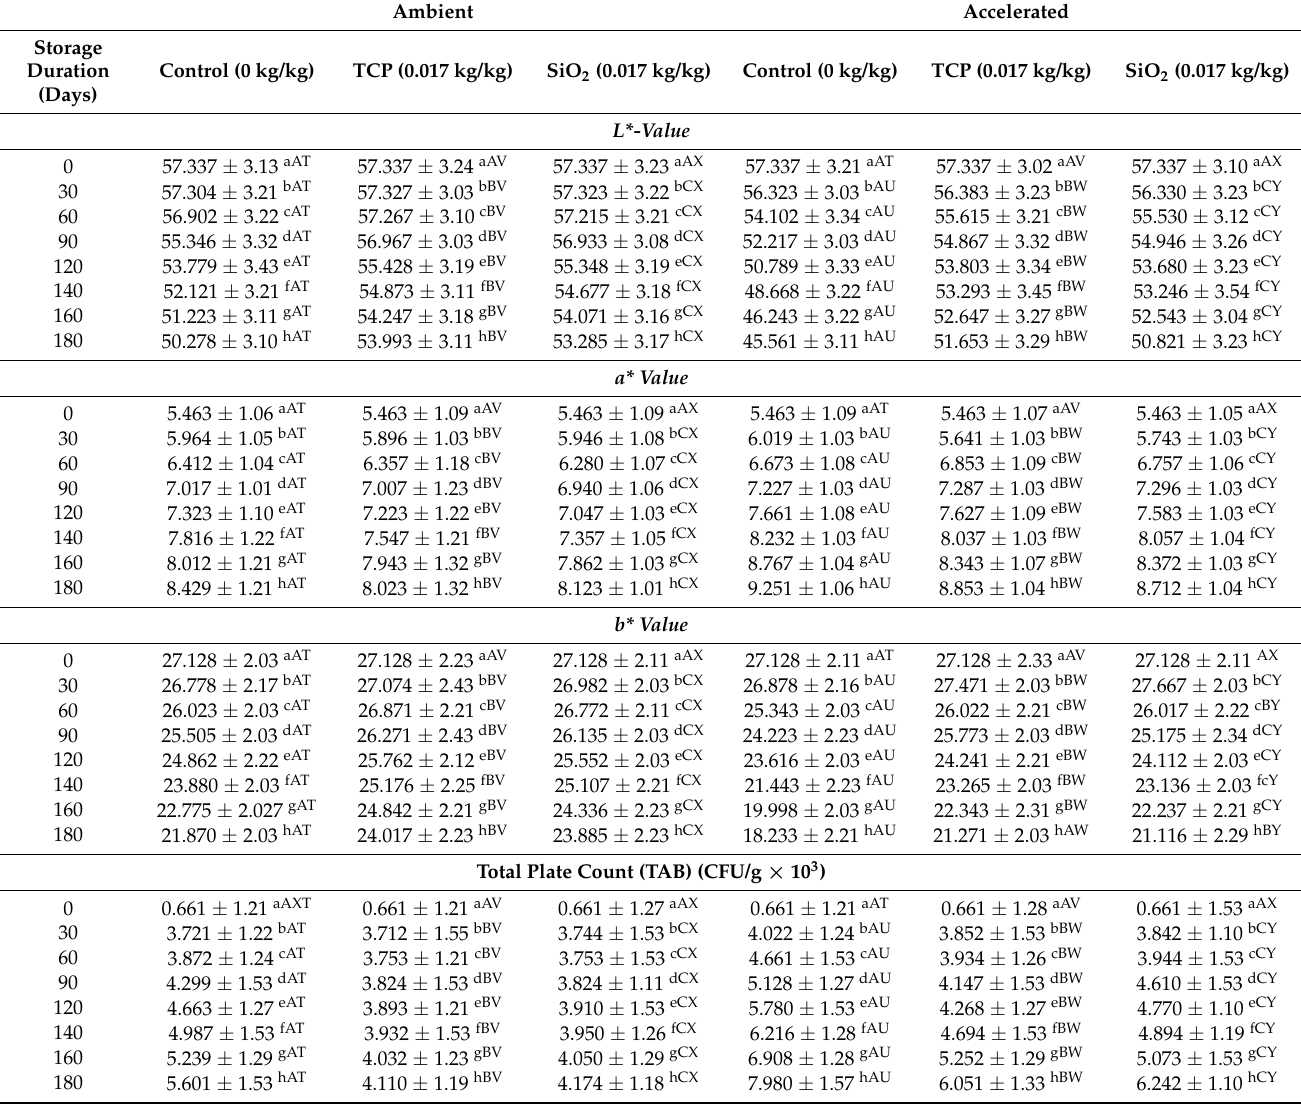
Table 3. Effect of storage duration, storage conditions (ambient and accelerated), and anticak- ing agents (TCP and SiO 2 ) on color profile and total plate count (TPC) of spray-dried apricot powder